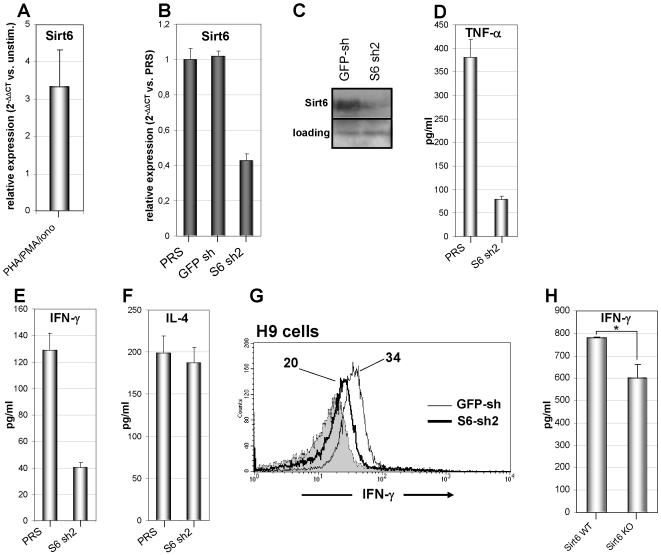
Evidence for an involvement of Sirt6 in IFN-γ synthesis.A, PBLs were cultured for 24 h with or without PHA. Thereafter, Sirt6 levels were detected by Q-PCR. mRNA levels in PHA-stimulated cells were compared to those in unstimulated PBLs. B, C, Jurkat cells were transduced with PRS, (PRS) GFP-sh, or (PRS) S6 sh2, subsequently, Sirt6 mRNA levels or Sirt6 protein levels were determined by Q-PCR (B) and immunoblotting (C). D–F, Jurkat cells transduced with PRS or S6 sh2 were stimulated for 12 h with 5 µg/ml PHA, 50 ng/ml PMA, and 0.5 µM ionomycin. Thereafter, supernatants were harvested and TNF-α (D), IFN-γ (E), and IL-4 (F) levels were determined by ELISA. G, H9 cells transduced with GFP-sh or S6 sh2 were stimulated for 12 h with 5 µg/ml PHA, 50 ng/ml PMA, and 0.5 µM ionomycin. Thereafter, intracellular IFN-γ was detected by intracellular staining. Mean fluorescence intensity for IFN-γ expression is indicated for each histogram. H, 3×106 splenocytes from wild type or Sirt6 KO mice/well were seeded in 24 well plates and stimulated for 24 h with 1 µg/ml Con A. Thereafter, supernatants were harvested and IFN-γ levels were determined by ELISA. *: p<0.05. Results are means ± SD of three experiments (A, B, D–F). Panel C and G are representative of three separate experiments.